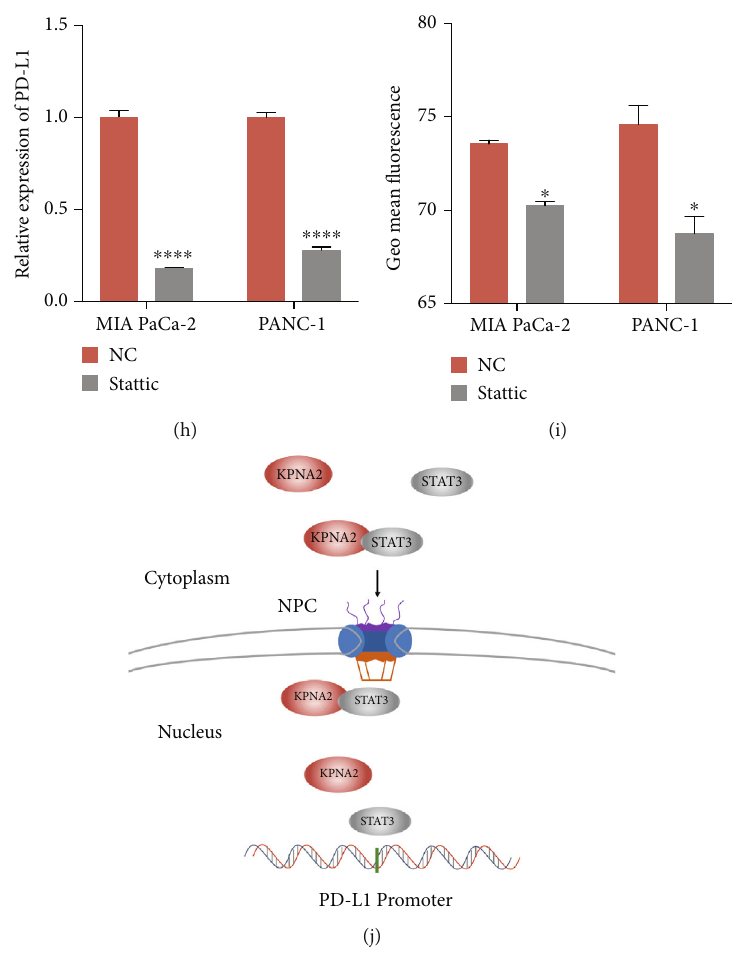
Figure 4: KPNA2 maintained the expression of PD-L1 by mediating nuclear translocation of STAT3. (a) GSEA analysis of KPNA2 expression in PDAC using the TCGA dataset. NES: normalized enrichment score. (b) Coimmuno fl uorescence of KPNA2 and STAT3 in MIA PaCa-2 and PANC-1 cells (scale bar: 10 μ m). (c, d) KPNA2 knockdown could inhibit the nuclear translocation of STAT3 in MIA PaCa-2 and PANC-1 cells (scale bar: 10 μ m). (e, f) The expression of nuclear p-STAT3 was detected in control and KPNA2 knockdown PDAC cells. Lamin B was used as the loading control of nuclear protein. (g) IHC staining of p-STAT3 in mouse tumor lesions inoculated with KPC1199-luc cell treatment with sh-KPNA2 or control vector (scale bar: 100 μ m). (h, i) Relative mRNA expression level and protein level of PD-L1 in PDAC cells treated with 2.5 μ M stattic, STAT3 inhibitor. (j) Proposed model for nuclear transporter KPNA2 promotes the PDAC